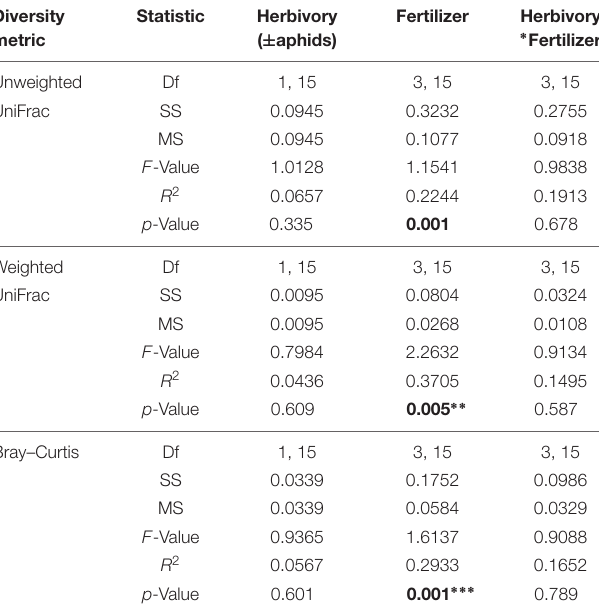
TABLE 4 | Results of permutational multivariate analysis of variance (PERMANOVA) analysis of dissimilarities for bacterial OTU community structure of 12 week cabbage rhizospheres in relation to herbivory ( ± aphids), fertilizer treatment and their interaction using UniFrac and Bray–Curtis